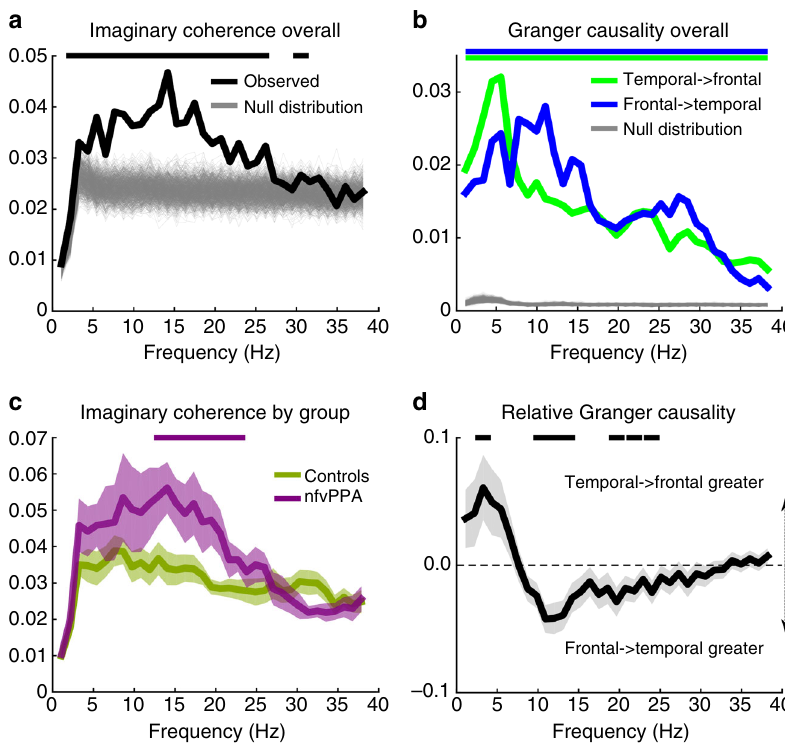
Fig. 8 Coherence and connectivity analysis. For the time series of frontal and temporal sources of interest between 0 and 900 ms after every spoken word onset. The evoked waveform was subtracted from the time series of frontal and temporal source activity between 0 and 900 ms after every spoken word onset before analysis. Horizontal lines at the top of each plot denote frequencies at which the line of matching colour statistically exceeds either the null distribution a and c , its counterpart condition ( b ) or differs from zero ( d ). A: Imaginary coherence. The median of the observed inter-source coherence is shown in black. 1000 randomisations of the null distribution are shown in grey. b Imaginary coherence by group. Shading represents standard error of the mean. c Granger causality. Median in fl uences from temporal to frontal sources are shown in green and frontal to temporal sources in blue. 1000 randomisations of the null distribution are shown in grey. d Relative normalised Granger causal relationships between temporal and frontal sources by frequency. Grey shading represents the standard error of the directionality contrast in a repeated measures general linear